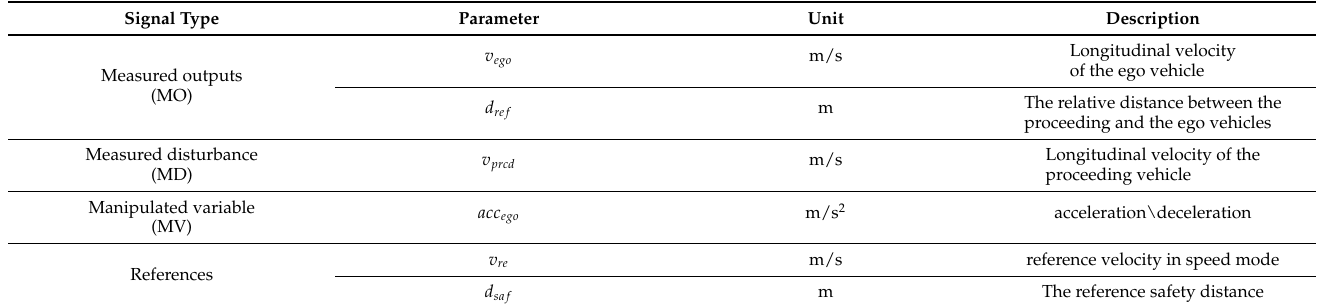
Table 1. Input/output signals of MPC controller.